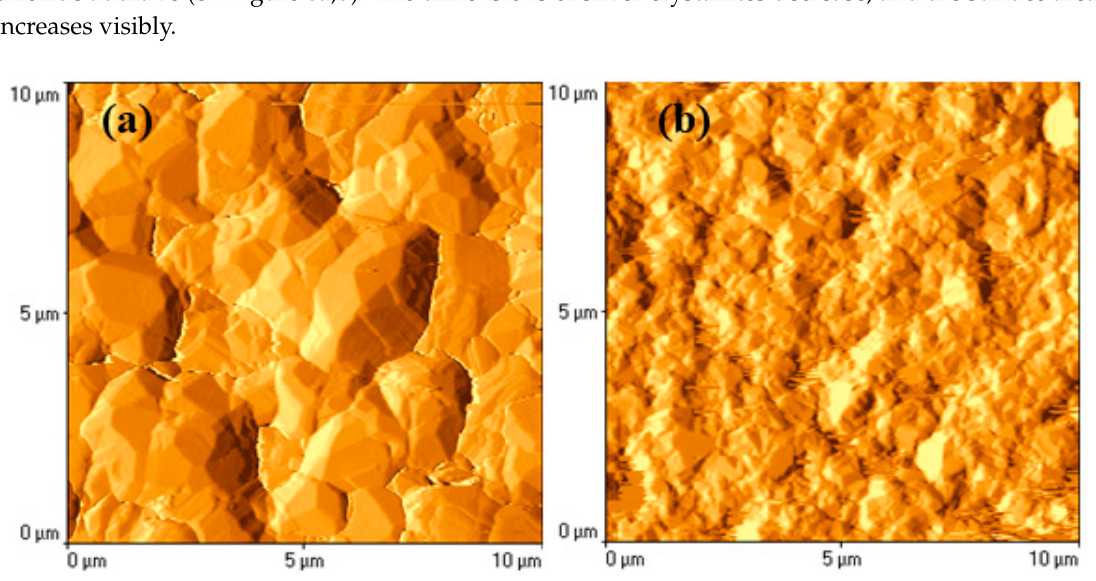
Figure 6. AFM images of silver coatings prepared without KCl additive ( a ) and with 100 mM KCl additive ( b ).